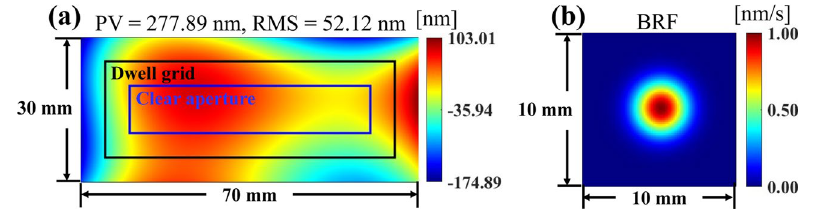
Figure 2. Simulated surface error map ( a ) and Gaussian BRF ( b